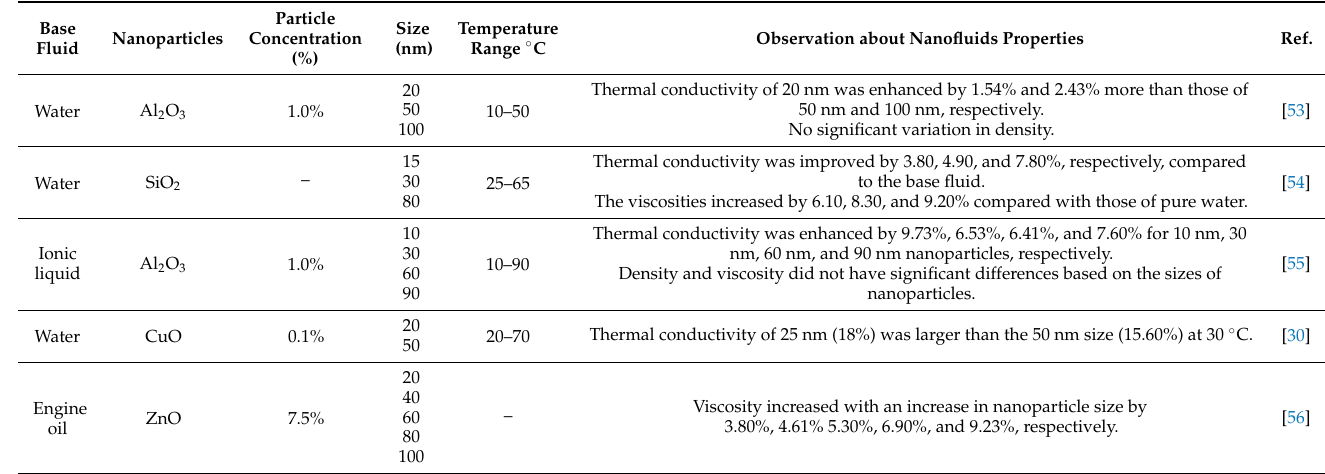
Table 4. Influences of nanoparticle size on nanofluid properties according to different studies.